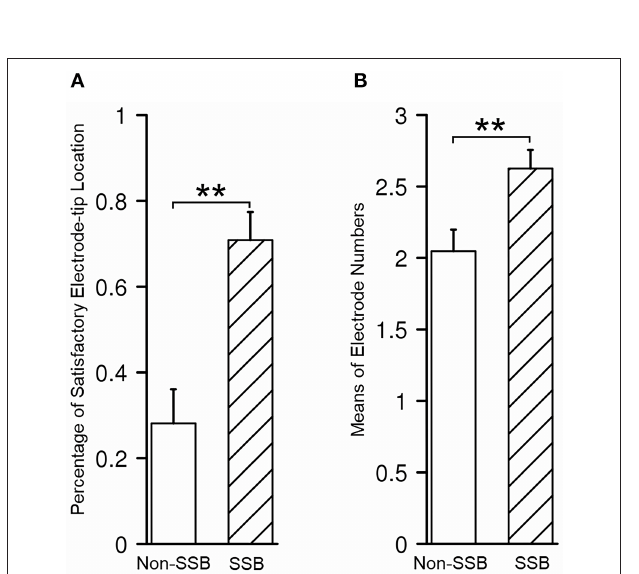
FIGURE 7 | Assessment of lead placement in trajectories with identified SSB and those without. (A) The percentage of satisfactory relative electrode tip location was higher in trajectories with identified SSB than those without. (B) The mean electrode number within STN was higher in trajectories with identified SSB than those without. SSB, boundary between subthalamic nucleus and substantia nigra. ** P < 0.001.